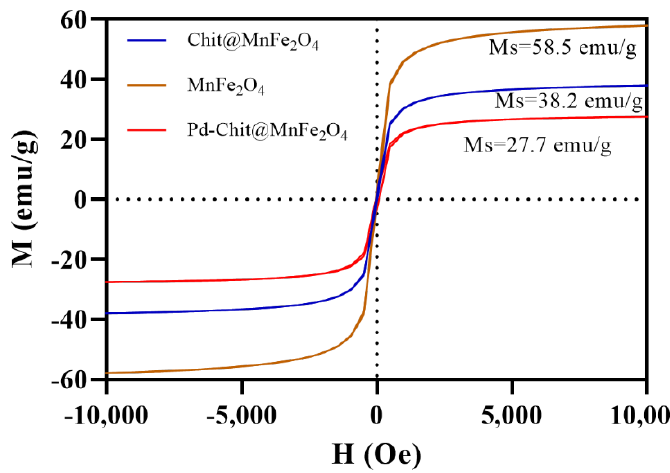
Figure 3. Magnetization curves of MnFe 2 O 4 , Chit@MnFe 2 O 4, and Pd − Chit@MnFe 2 O 4 .